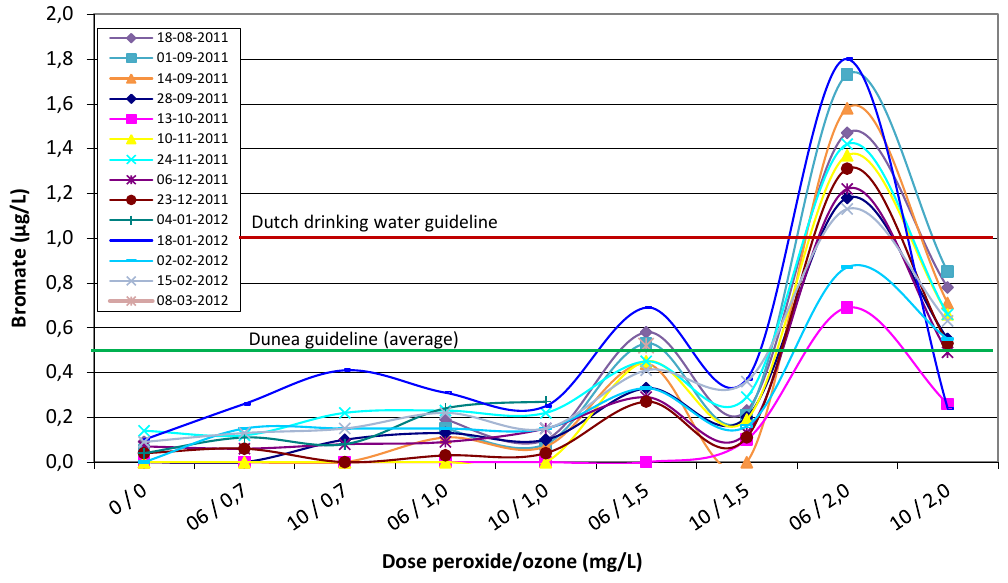
Figure 5. Bromate concentration at standard settings ( n = 14, August 2011 up to and including March 2012, data points are connected to improve the